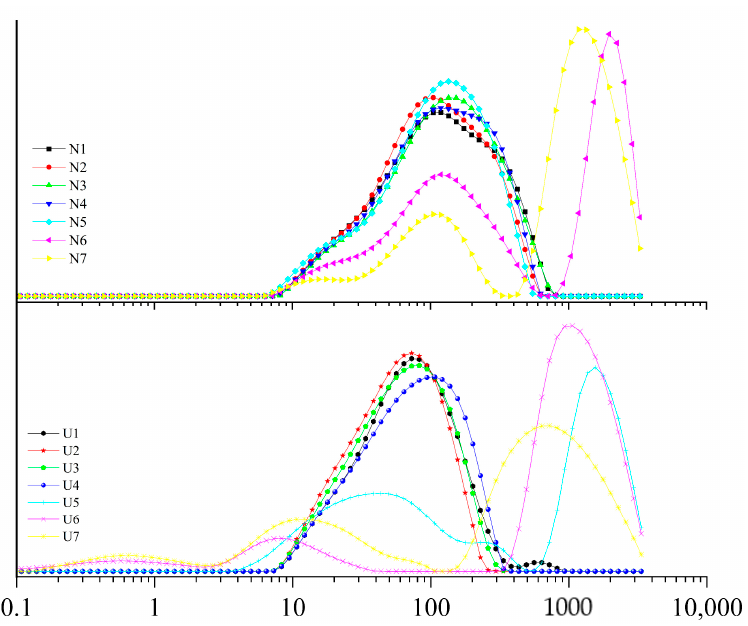
Figure 5. The droplet distribution of emulsions as affected by ultrasound emulsification. Table 2. Changes in D3,2, D4,3 and span value of emulsions before (non-ultrasound, N) and after ultrasound (U) emulsi- fication treatment.